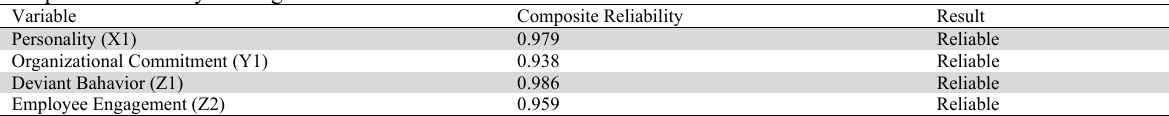
Composite Reliability Testing